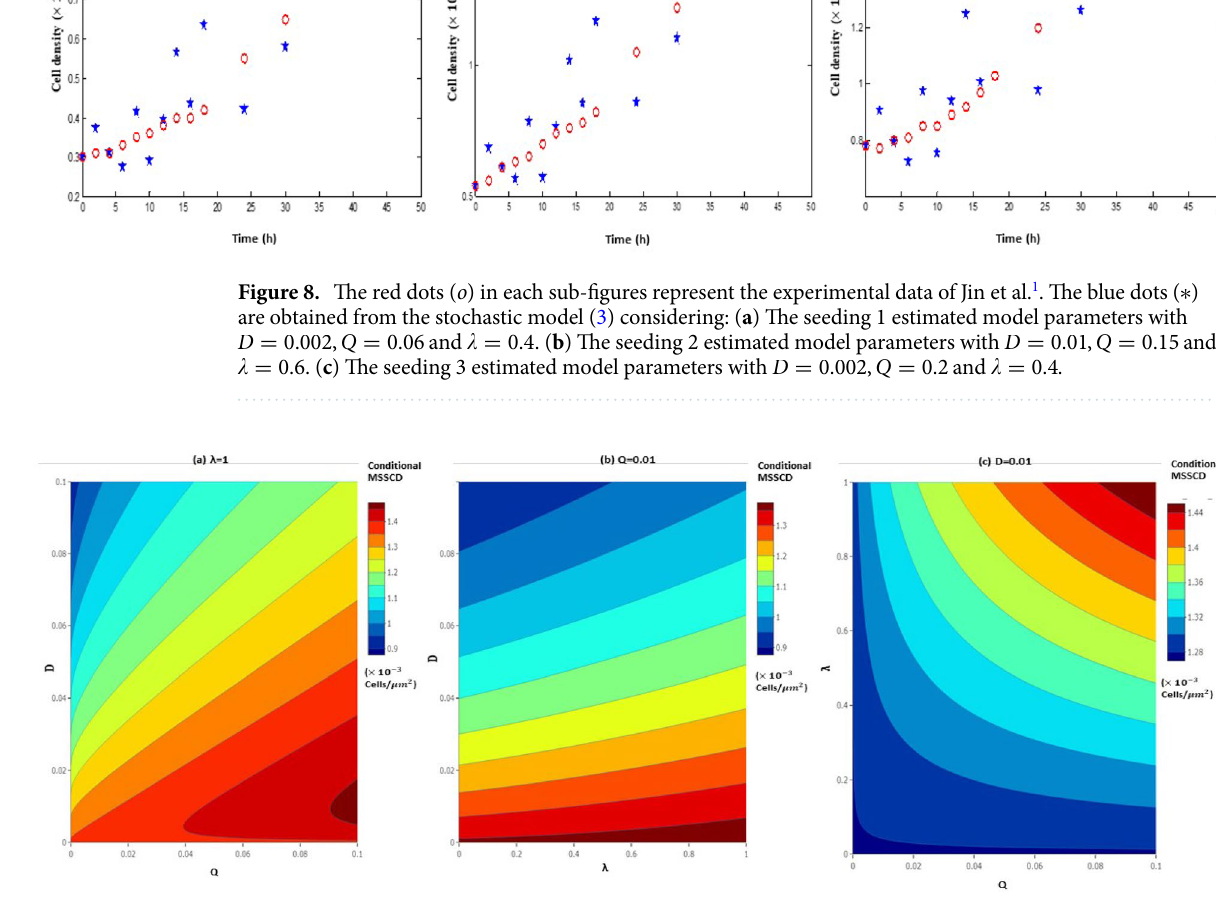
Q noise strength plane − (cid:31) noise plane with Q 0.01 ; ( c ) the 1 ); ( b ) the conditional MSSCD values in D = = − (cid:31) noise plane with D 0.01 − =